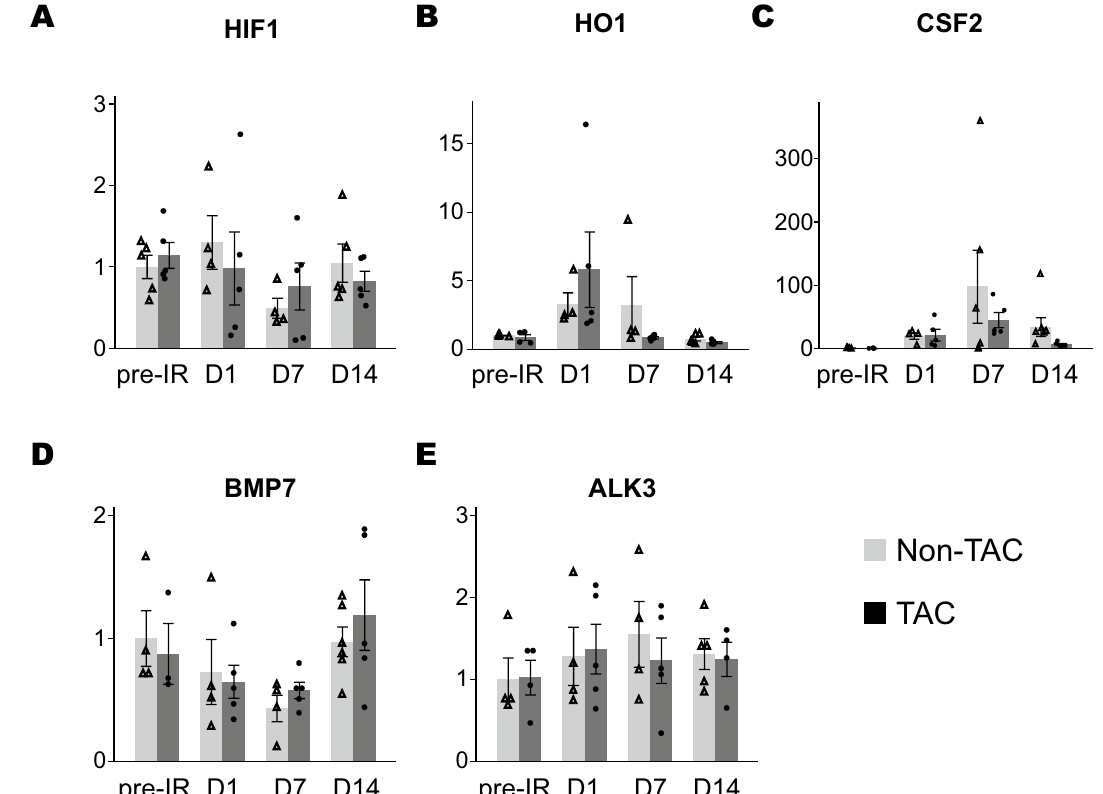
Figure 6. Relative transcript level of genes related with anti-fibrotic pathway (Experiment 2). mRNA levels of ( A ) HIF1, ( B ) HO-1, ( C ) CSF2, ( D ) BMP7 and ( E ) ALK-3 in the kidneys of non-TAC and TAC mice are shown (n = 4–5 per group) after IR. Gray bar and open triangle, non-TAC mice; black bar and filled circle, TAC mice. All graphs were created using JMP 14.0 software (SAS Institute Inc., Cary,